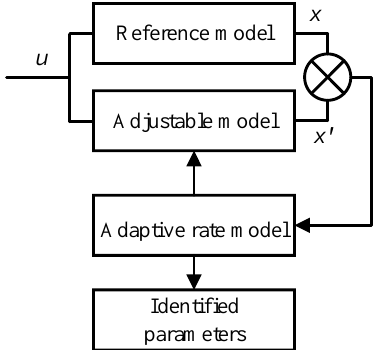
Figure 1. Structural block diagram of the